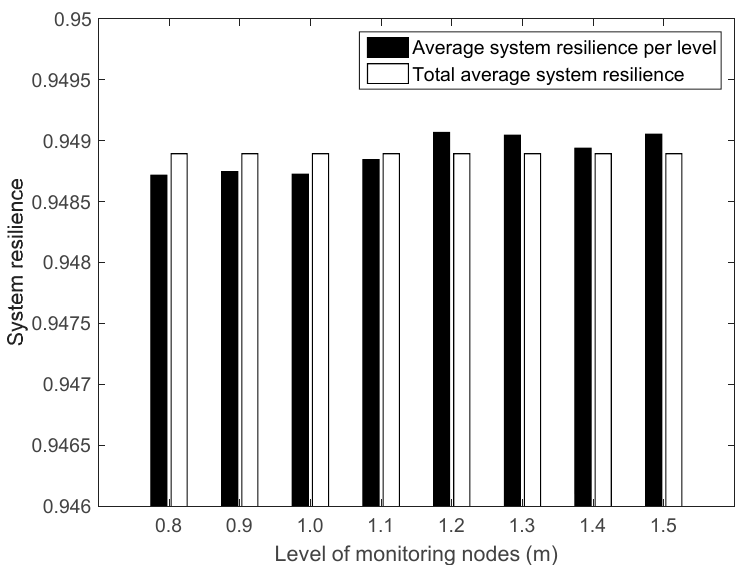
Figure 6. Comparison of average system resilience (black) and total system resilience (white) compared with monitoring node water level.